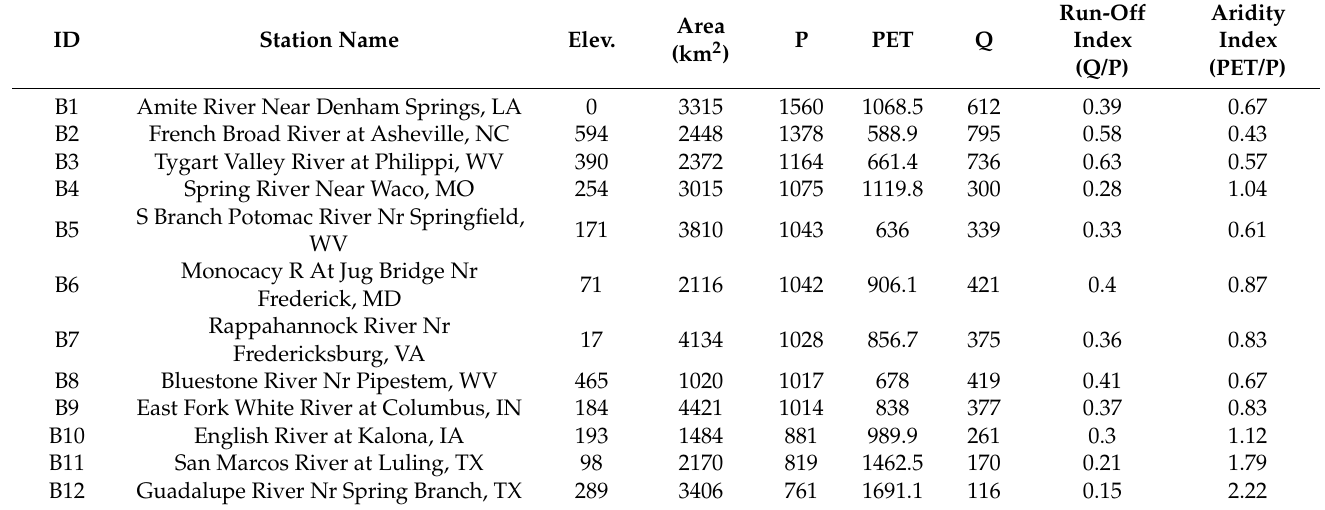
Table 1. Hydrological information about the 12 catchments selected from the Mopex project.